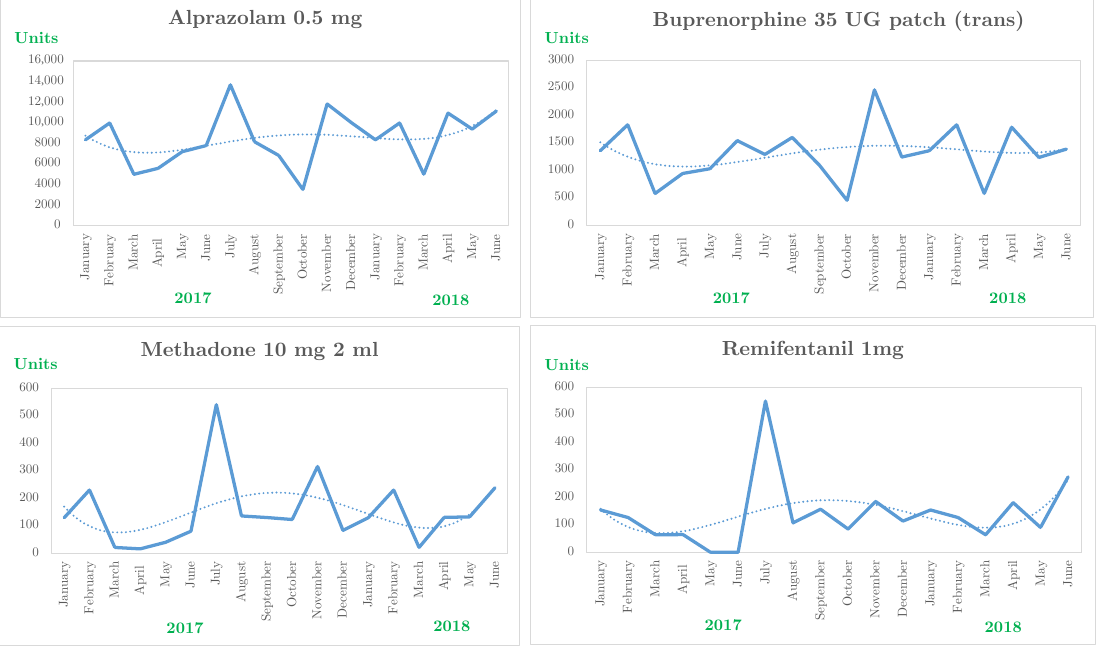
Figure 2. Monthly demand (solid line) and polynomial 4-degree regression (dashed line), in units, of four controlled medications for the period January 2070–June